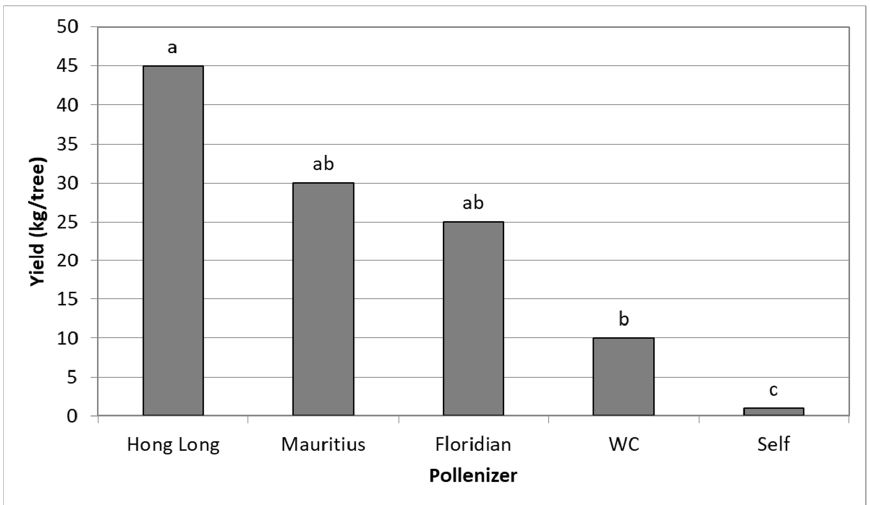
Figure 4. The effect of different pollinizers under nets on yield of the adjacent TA trees, Ravid 2020. Mean values of each column (pollinizer) followed by different letters differ significantly by Dun- can’s new multiple range test, p < 0.05. Data on yield are the mean of 4 TA trees (4